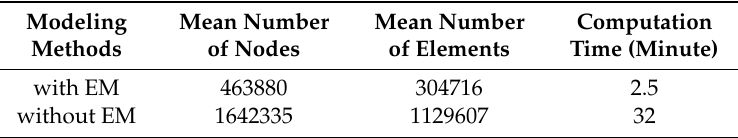
Figure 8. The principle of the modal experiment.